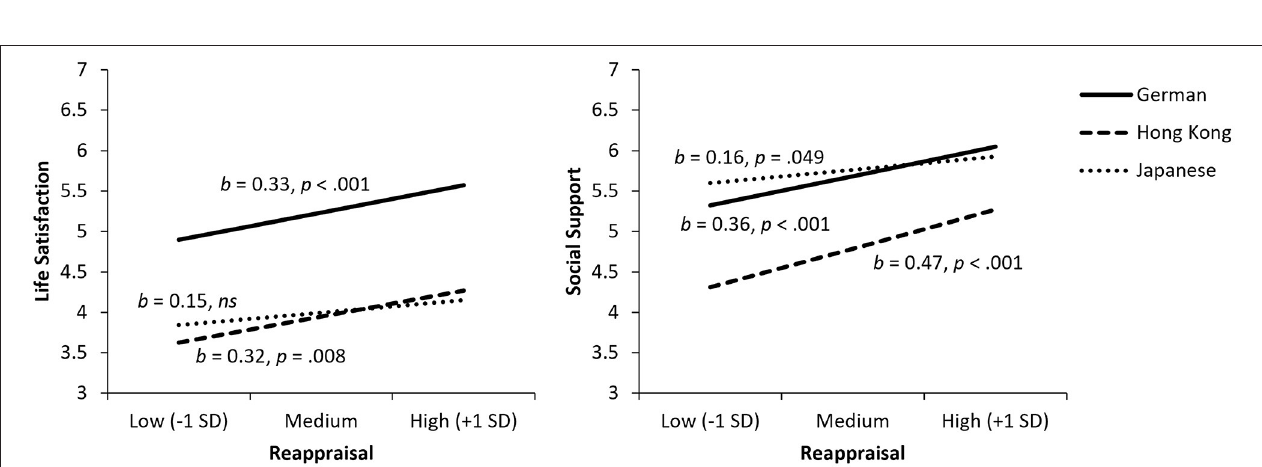
FIGURE 2 | Relationships of reappraisal with life satisfaction (left) and social support (right). ns, not statistically significant.